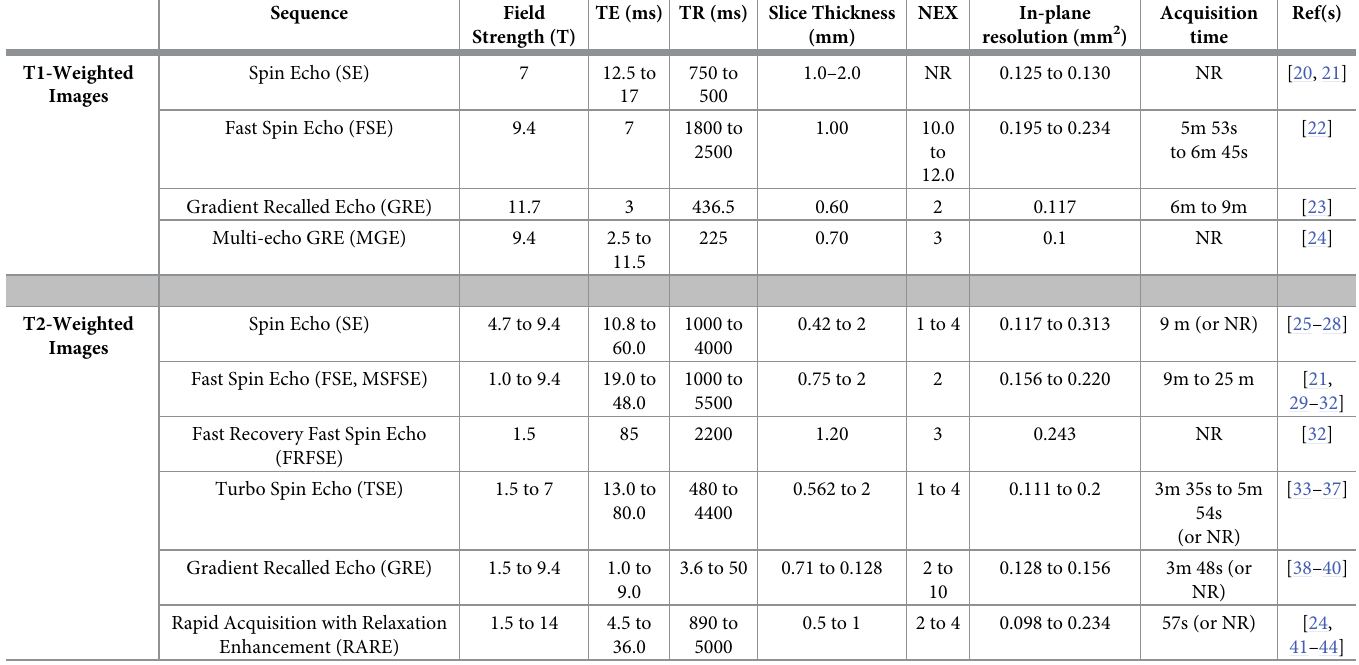
Table 1. Samples found in the literature on preclinical MR sequences for solid tumor volume measurements in mice.